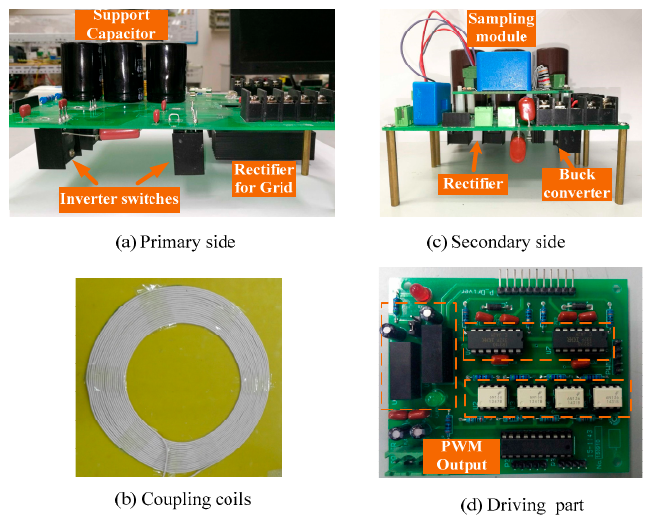
Figure 13. Demo SC-load wireless power transfer (WPT) system ( up ) and each part ( down ).